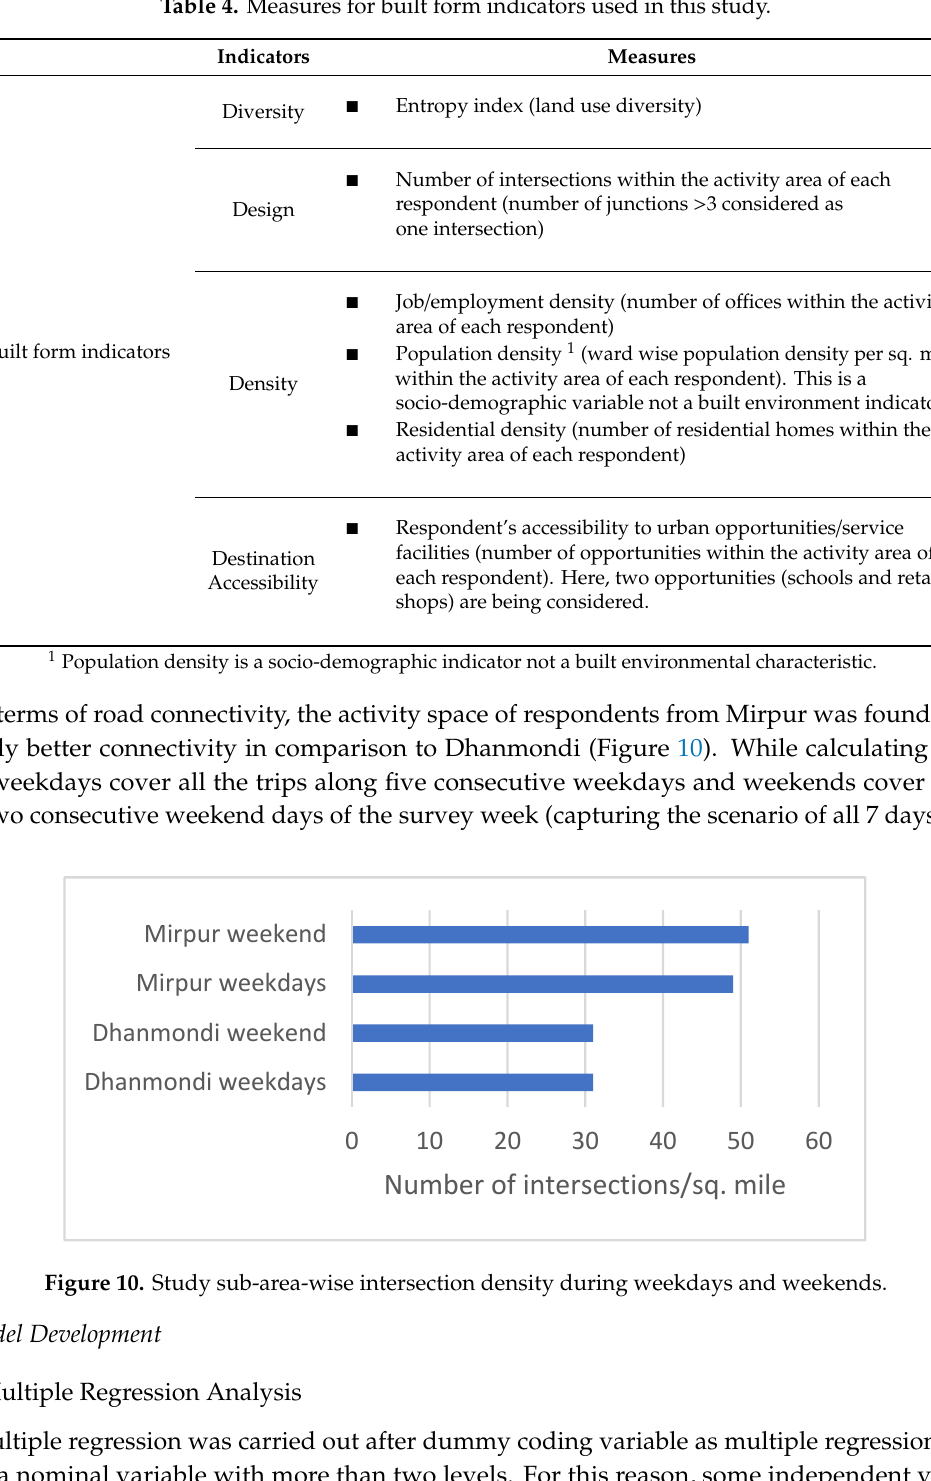
Table 4. Measures for built form indicators used in this study.